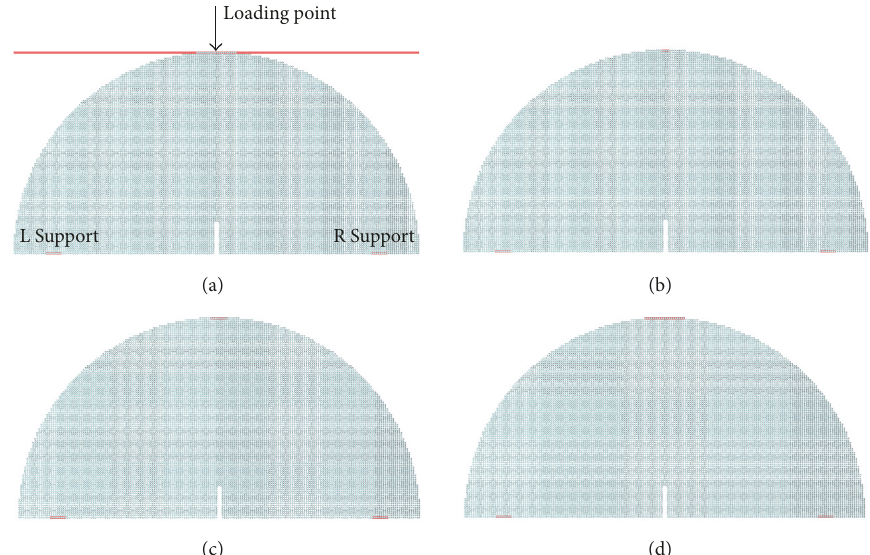
Figure 16: Four DLSMs for each of the four different loading areas.